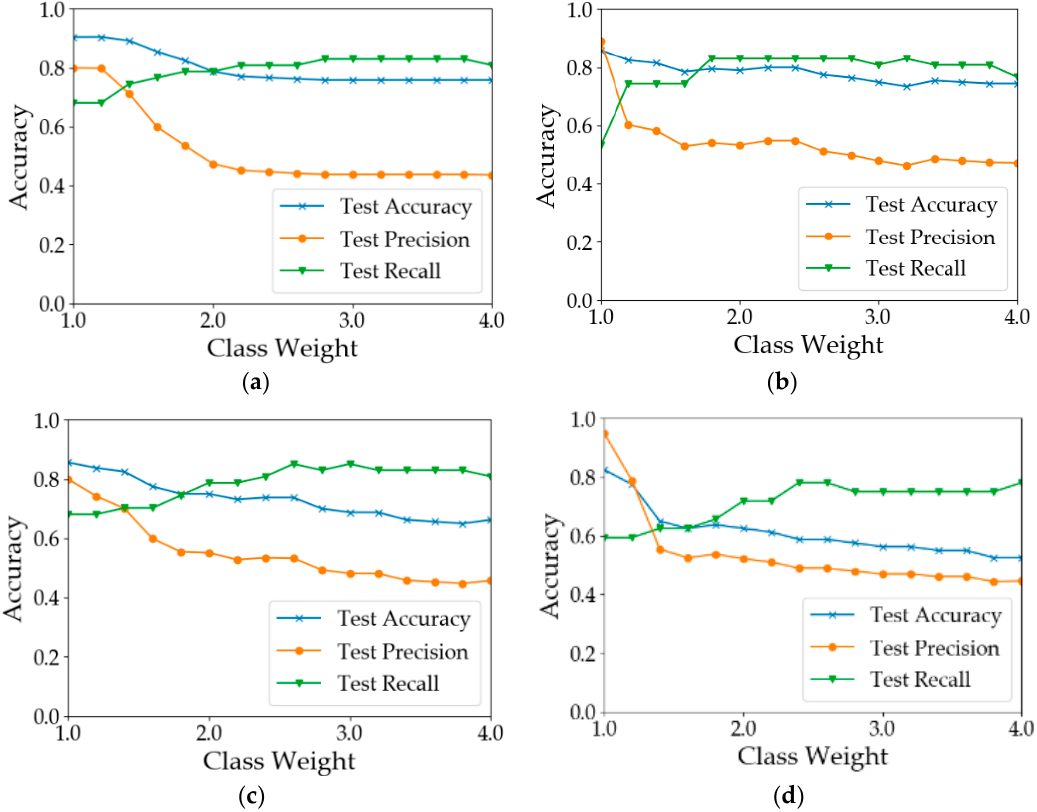
Figure 8. Test accuracy, precision and recall using different weights for the minority class. ( a ) Results of Calculation I ( b ) Results of Calculation II ( c ) Results of Calculation III ( d ) Results of Calculation IV